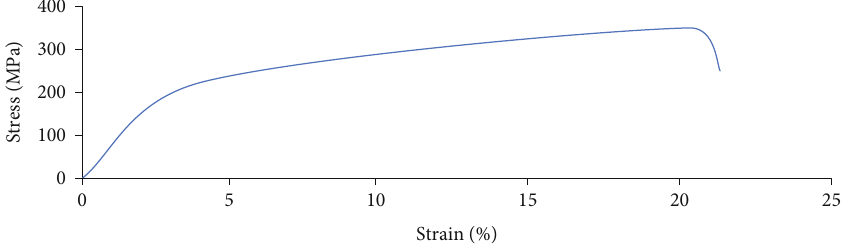
Figure 3: Ni-Ti shape memory alloy stress-strain curve (transitions start at 89.11 ° C and end at 86.33 ° C for the martensite phase, and the austenite phase begins at -22.73 ° C and ends at around 91.96 ° C) [18].